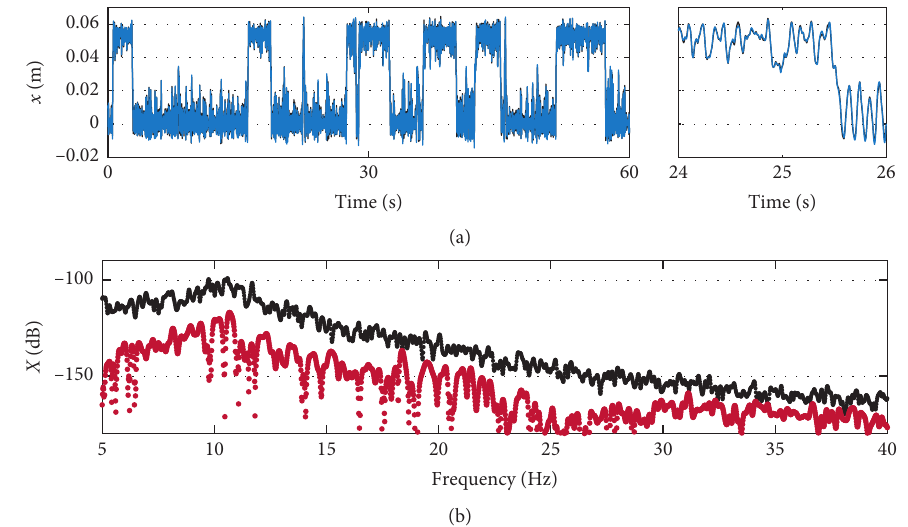
Figure 23: Validation of the nonlinear identification in the time domain (a) and frequency domain (b). Black line: measured output; blue line: simulated output; red dots: residual with the measured output spectrum in dB scales (ref. 1m 2